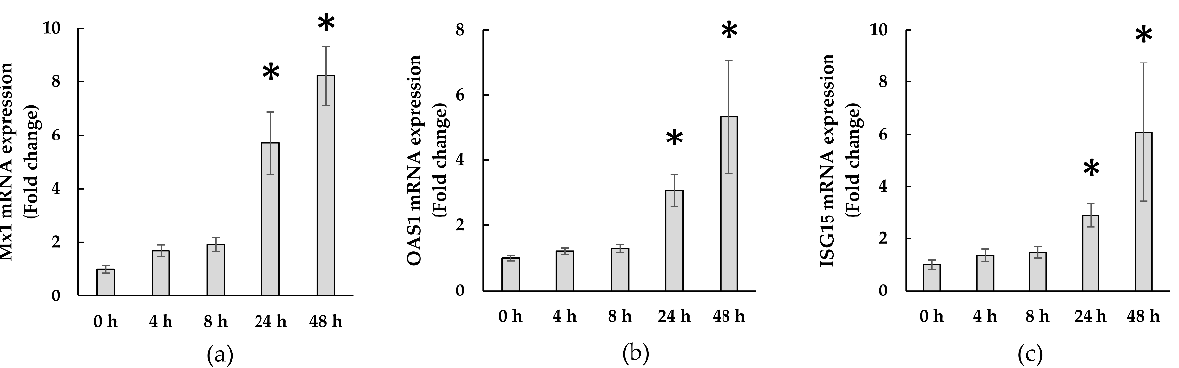
Figure 4. Gene expressions of ( a ) Mx1, ( b ) OAS1 , and ( c ) ISG15 . The values are shown as means ± SE. Asterisks mean a significant difference when compared to 0 h ( p -value ˂ 0.05). Data from six independent experiments are shown. independent experiments are